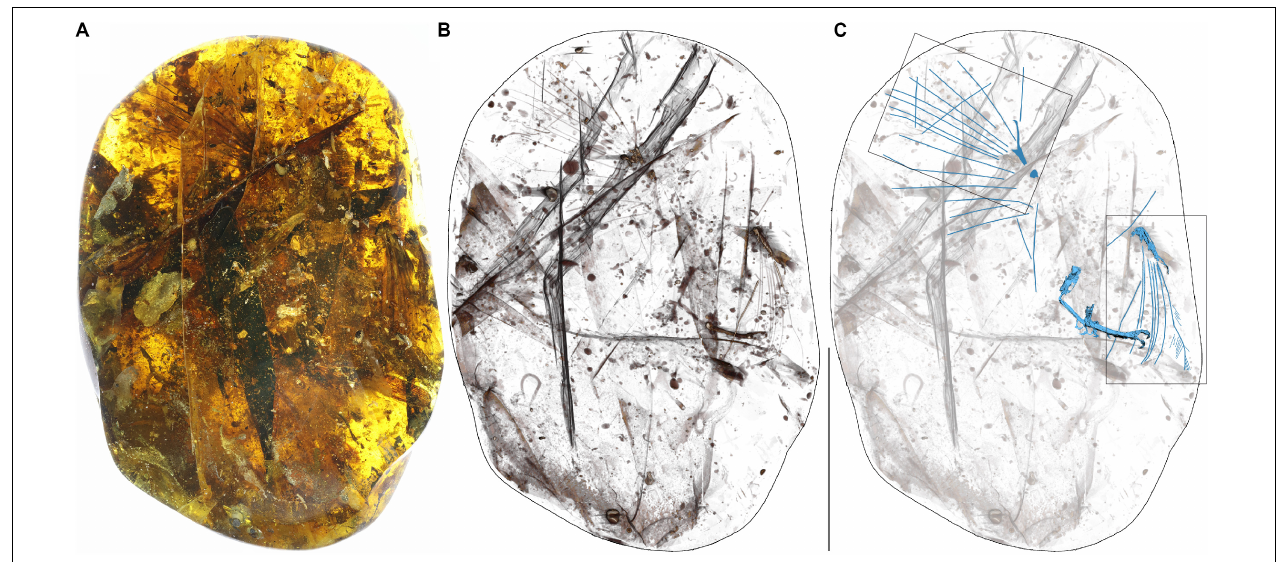
FIGURE 1 | Photograph of the amber specimen (A) , X-ray (B) and CT scan (C) . In the CT scan the bird bones and primary rachises are indicated in blue. Scale bar equals 50 mm. Boxes indicate areas enlarged in Figures 4A,F